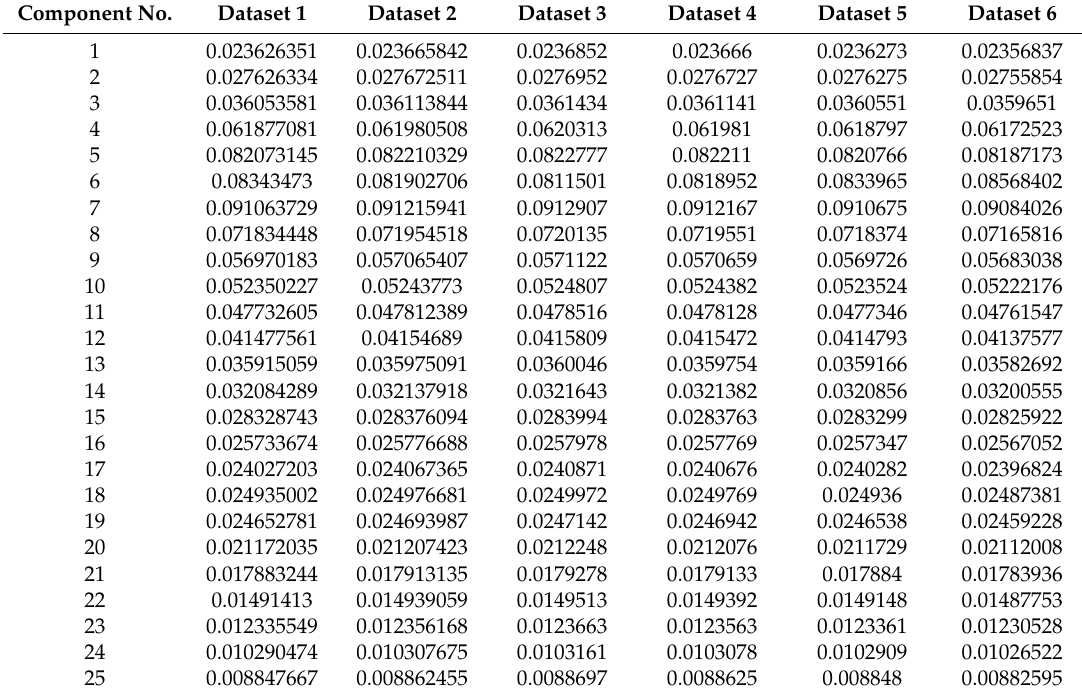
Table 8. Six sample variants of Zamzama